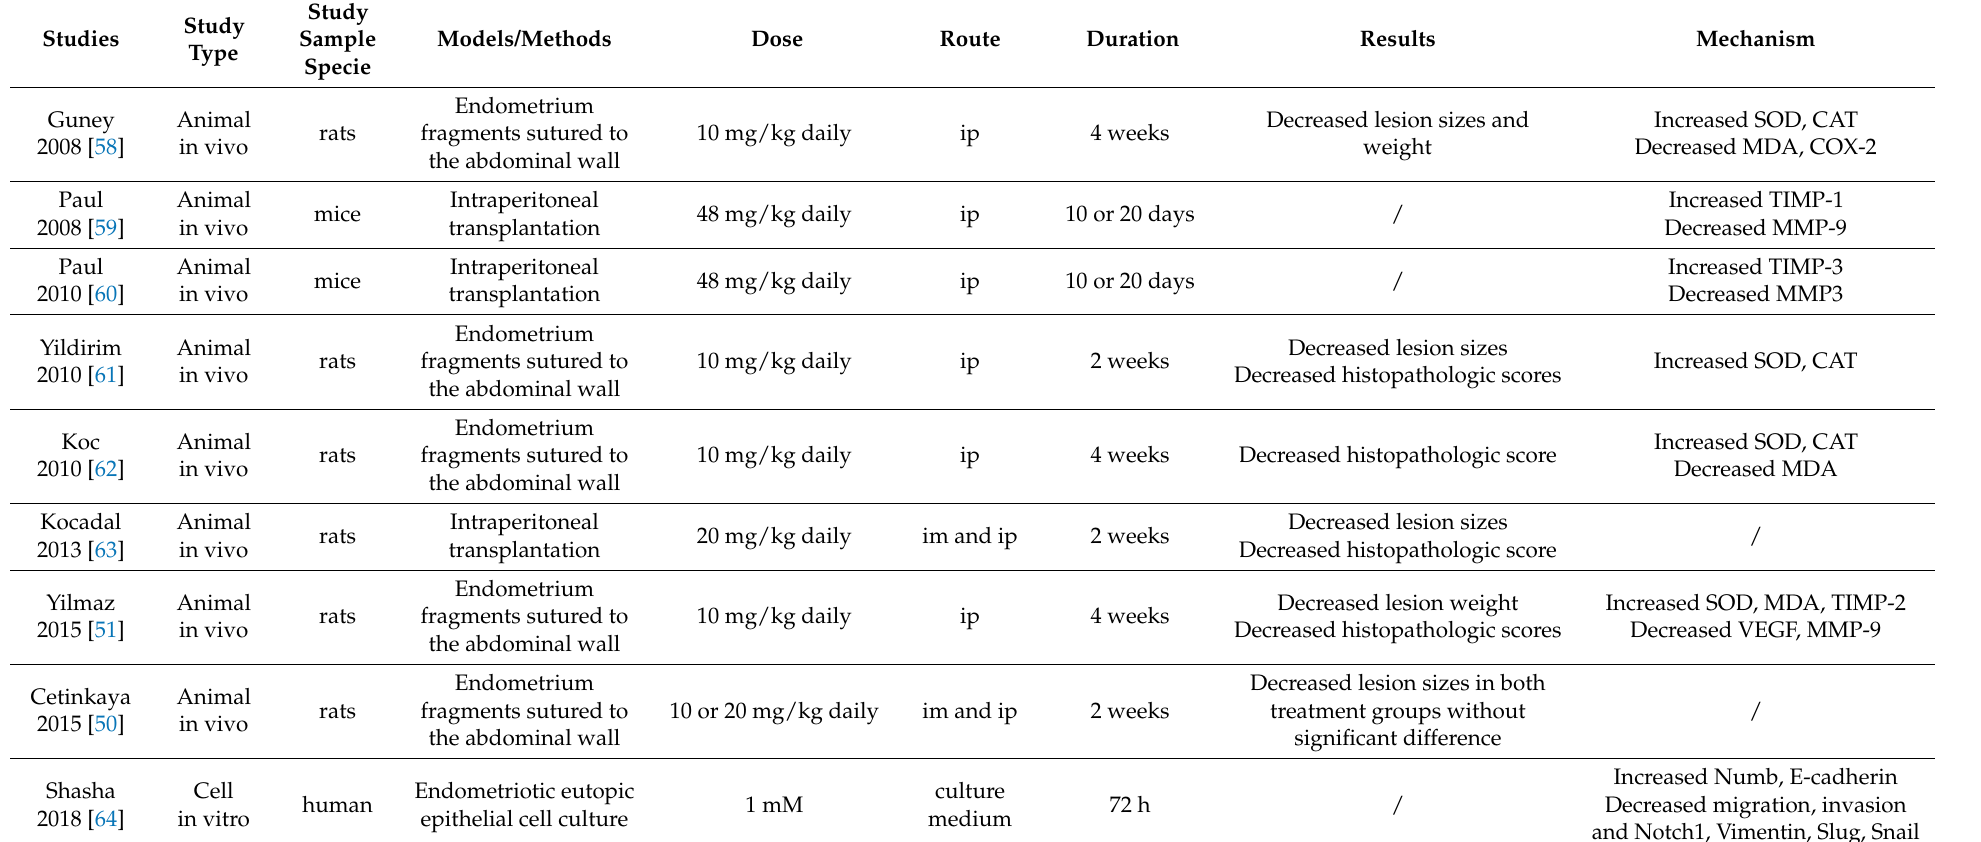
Table 1. Experimental studies of melatonin for